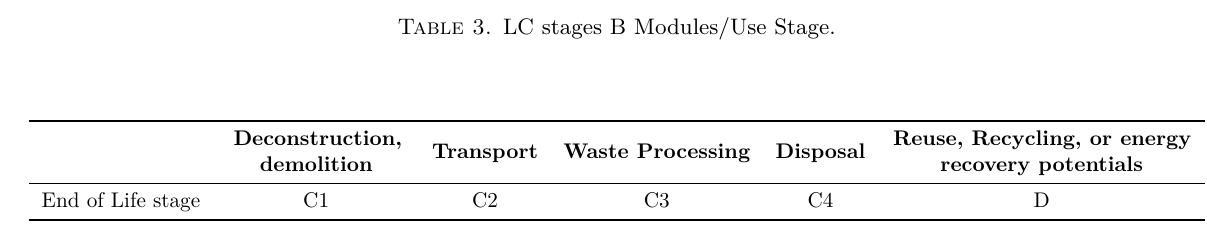
Table 4. LC stages C/D Modules / End of